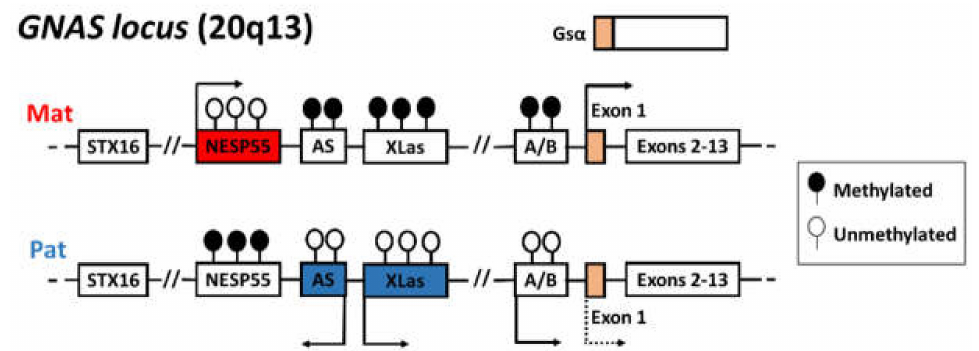
Figure 1. The imprinted GNAS locus (20q13.3) encodes multiple transcripts, including Gs α , XL α s , NESP55, and A/B. These isoforms have four alternative promoters and unique first exons, and they share the exons 2–13. The initiation of maternal- and paternal-specific transcripts is shown by arrows. The first exon of the Gs α gene is biallelically expressed in most tissues, but there is a preferable expression of the maternal allele in some specific tissues. Filled lollipops represent methylated DMRs and empty lollipops represent the unmethylated